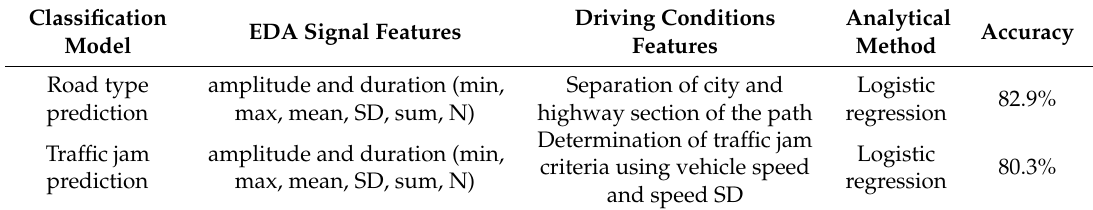
Figure 5. Stepwise development and application of the models. Table 4. Specification of classification